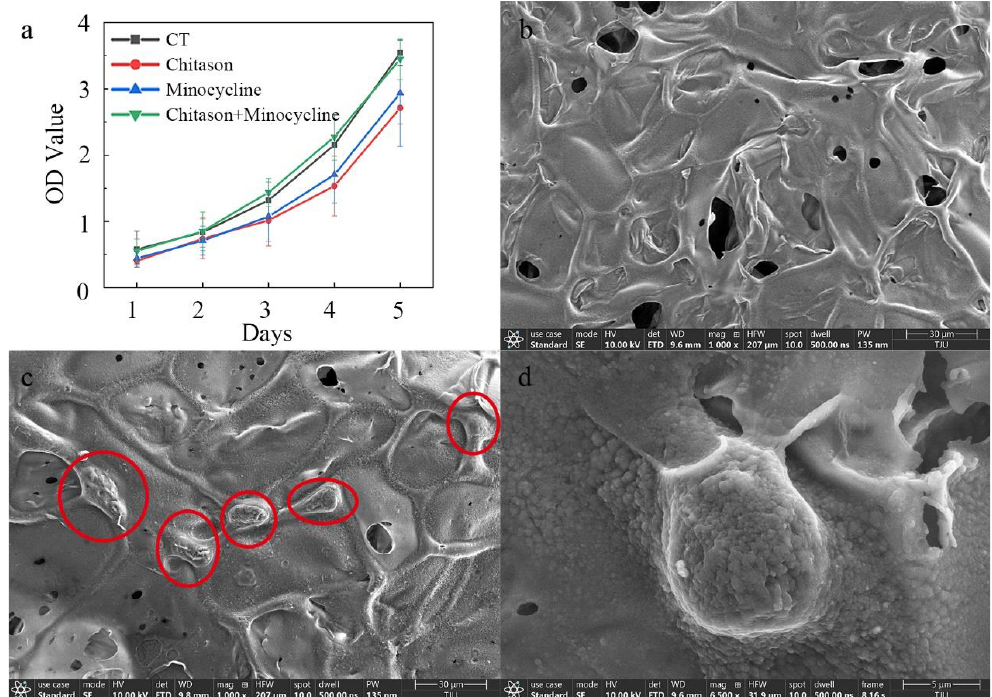
Figure 8. Characterization of osteogenic performance. ( a ) The OD value of the control and minocy- cline conditions across 5 days. ( b ) SEM image of chitosan substrate surface without osteoblasts. ( c ) SEM image of chitosan substrate surface with osteoblasts ( 30 μm scale ). ( d ) SEM image of chitosan substrate surface with osteoblasts ( 5 μm scale ).